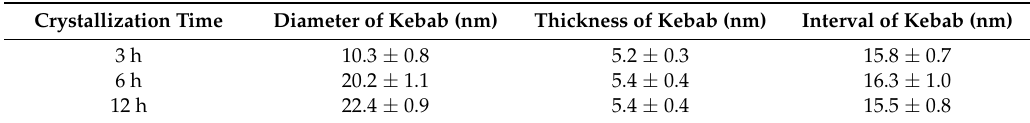
Figure 2. TEM images of PE21M/SWCNT nanocomposites produced by crystallization of PE21M on SWCNTs in p -xylene at 50 ◦ C for different isothermal crystallization time. ( a ) 3 h, ( b ) 6 h, and ( c ) 12 h (both PE21Br and SWCNT concentrations are 0.05 wt %). Table 2. The average size of PE21M lamellae formed on CNTs for different isothermal crystallization time based on the TEM images of 200